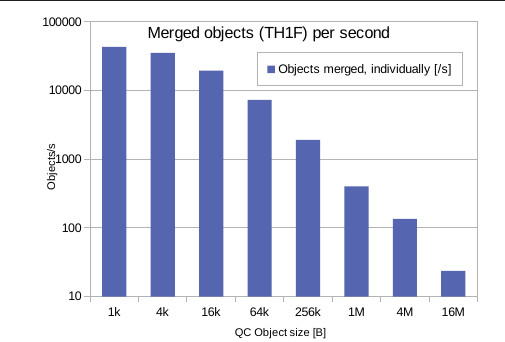
Figure 5. The performance of Checker as a function of the checks number per